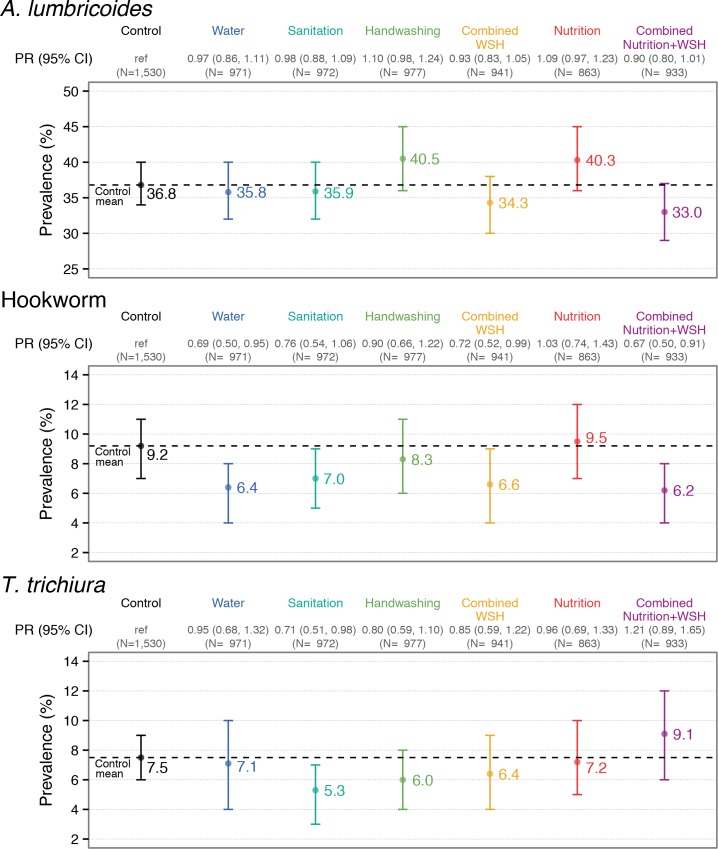
Prevalence and prevalence ratio (PR) for A. lumbricoides, hookworm, and T. trichiura infection in children aged 2–12 years measured with double-slide Kato-Katz 2.5 years after intervention initiation. Vertical bars indicate 95% confidence intervals.